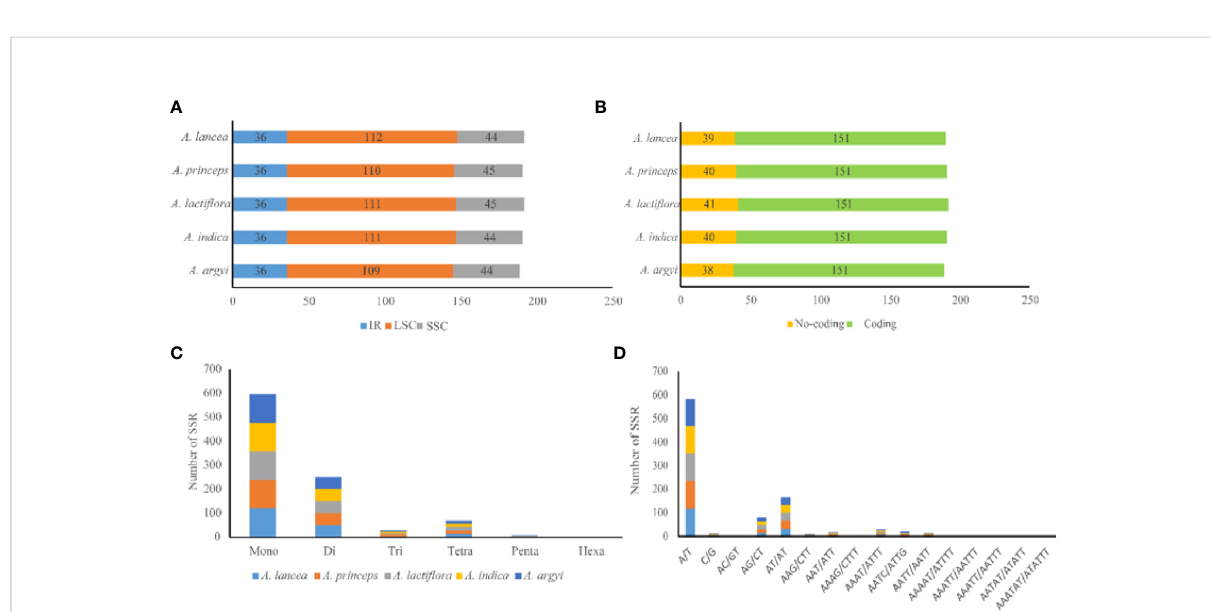
FIGURE 3 Type and distribution of SSRs in the fi ve Artemisia cp genomes. (A) Frequency of SSRs in the LSC, SSC, and IR regions. (B) SSR distribution between coding and noncoding regions. (C) Number of SSR types. (D) Number of identi fi ed SSR motifs in different repeat class types. SSR, simple sequence repeat; LSC, large single copy region; SSC, small single copy region; IR, inverted repeat region.